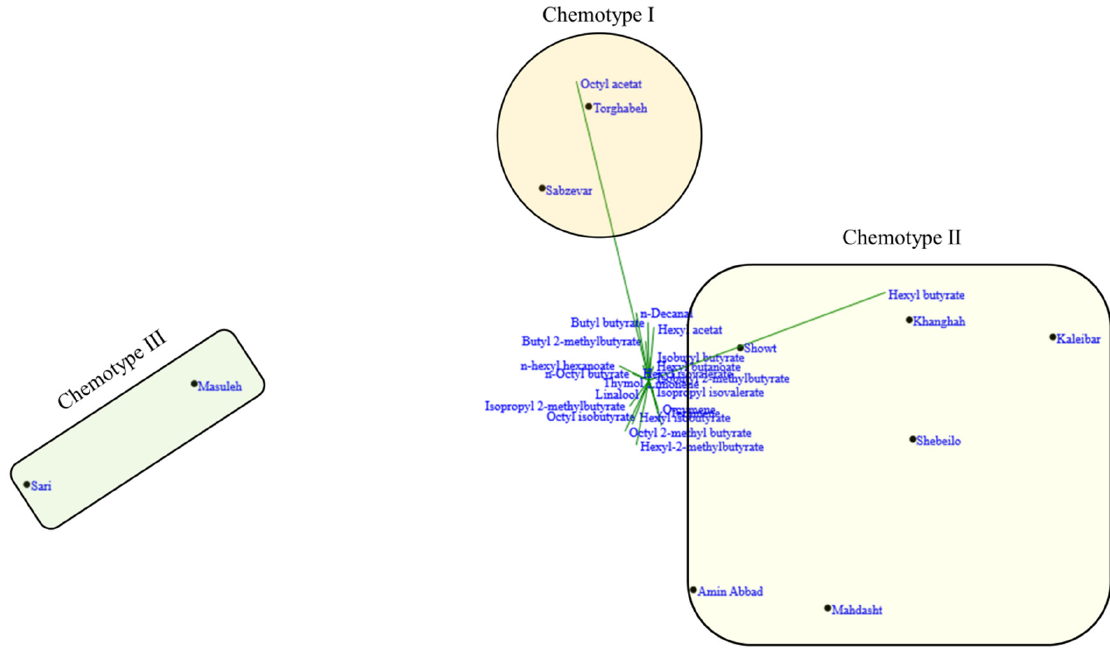
Figure 3. PCA biplot analysis of H. persicum populations based on phytochemical traits.